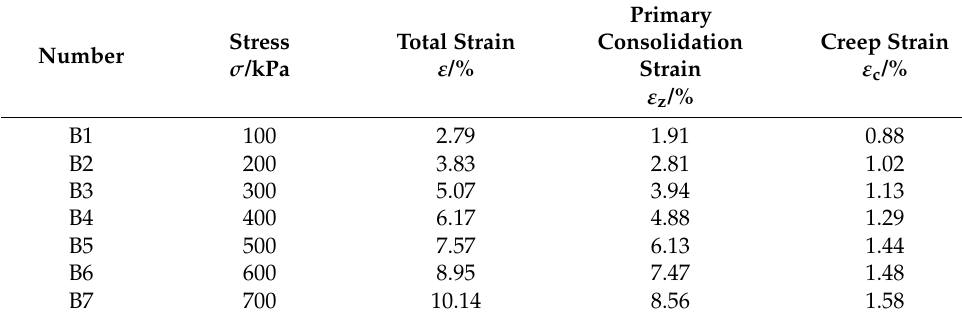
Table 6. Strain of silty clay under different vertical